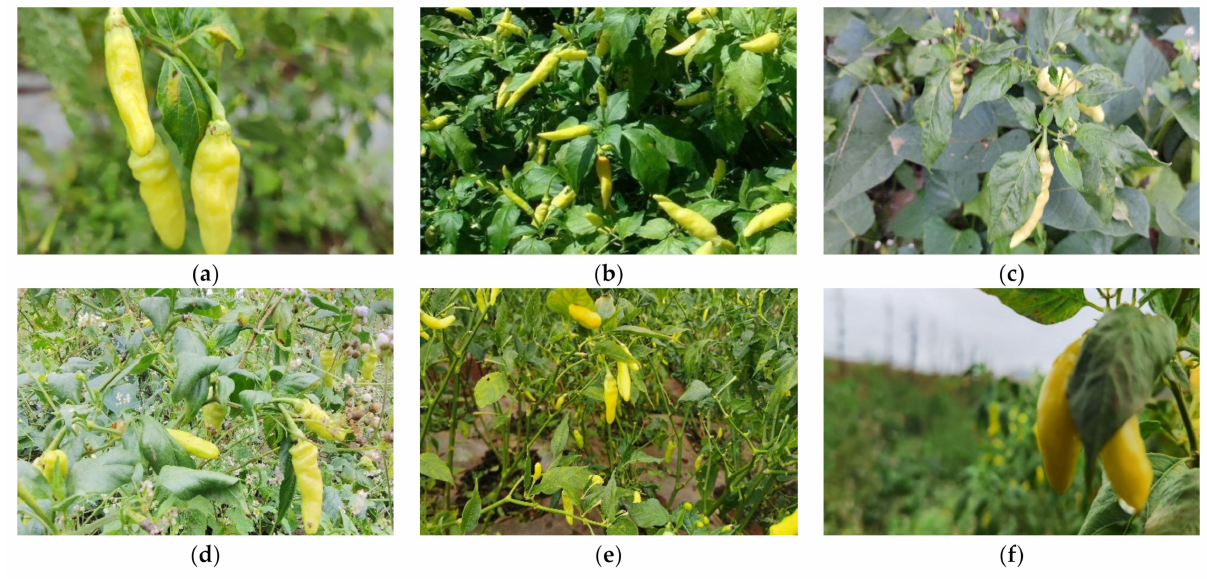
Figure 2. Images of Xiaomila green pepper under different conditions. ( a ) A single cluster of Xiaomila green pepper, cloudy, with no obvious occlusion; ( b ) a cluster of Xiaomila green peppers, sunny, with backlight; ( c ) Xiaomila green peppers covered by leaves; ( d ) in the afternoon with sufficient light, covered by branches and pedicels; ( e ) small target of Xiaomila green peppers, in the early morning, covered by branches; ( f ) fruit hanging with